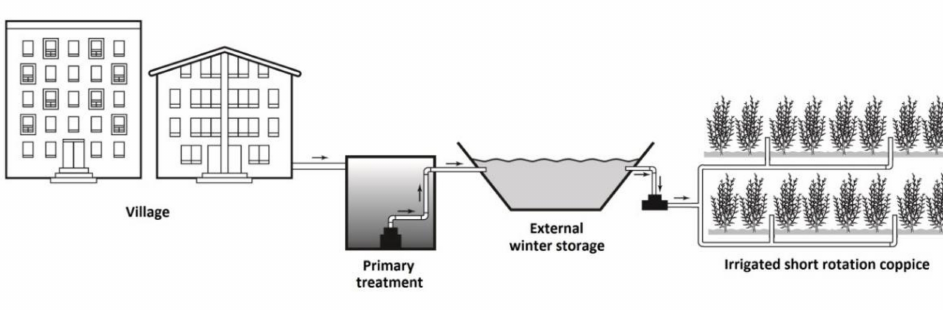
Figure 1. Option A: Operation of a wastewater irrigated short rotation coppice system with “external winter